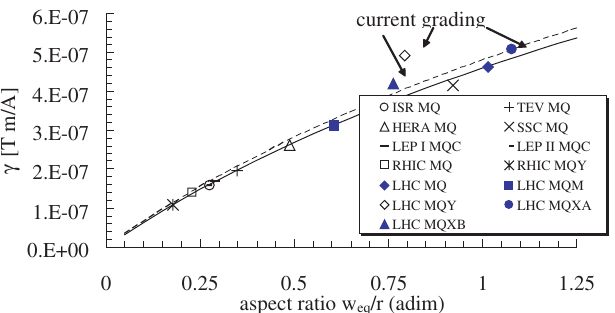
FIG. 24. (Color) Parameter (cid:4) (field gradient per current density) for 13 accelerator quadrupoles without iron (markers) and results for a 30 (cid:9) sector (dashed line) and [0 (cid:9) –24 (cid:9) ,30 (cid:9) –36 (cid:9) ] sector (solid line) versus aspect ratio as defined in Eq. (41).